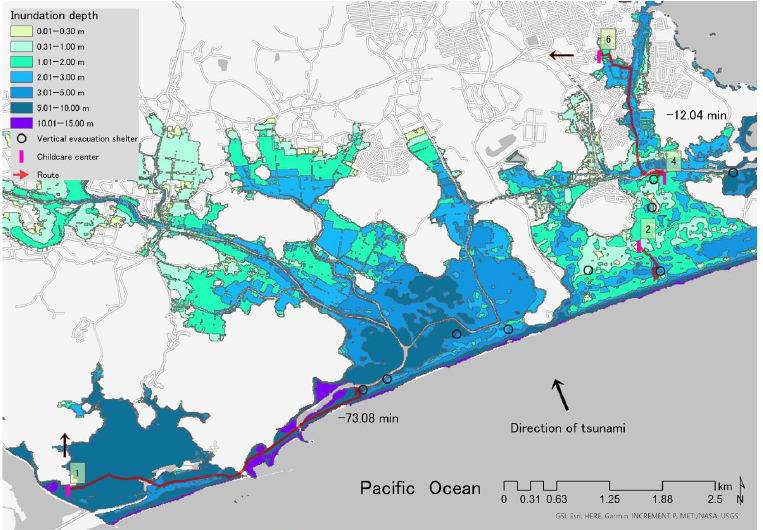
Figure 5. Routes to the nearest vertical evacuation shelter of childcare centers ID1 and ID6 and the direction of rapid evacuation from the tsunami. The direction required for rapid tsunami evacuation is indicated by a black arrow with a red border.